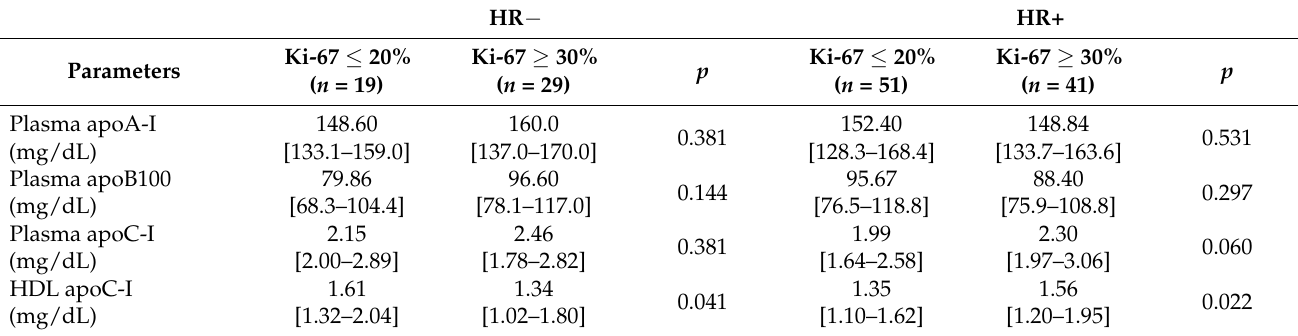
Table 3. Concentration of plasma, HDL and non-HDL apolipoproteins in estrogen receptor-positive (HR+) and negative (HR − ) breast cancer patients, according to the proliferation index (Ki-67 ≤ 20% or Ki-67 ≥ 30%). Data are presented with median (25th–75th percentile). HR −